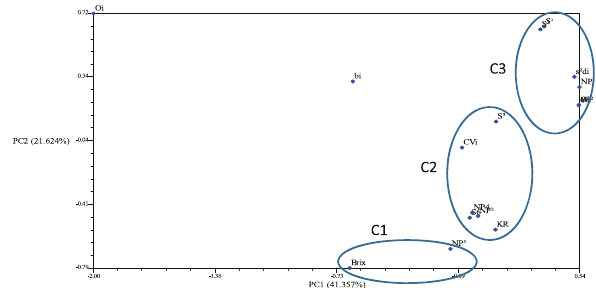
Figure 2: PCA biplot for depicting the relationship between sweet - ness and numerical stability measurements in 16 genotypes of honey sweet potato at six locations in West Java, Indonesia.